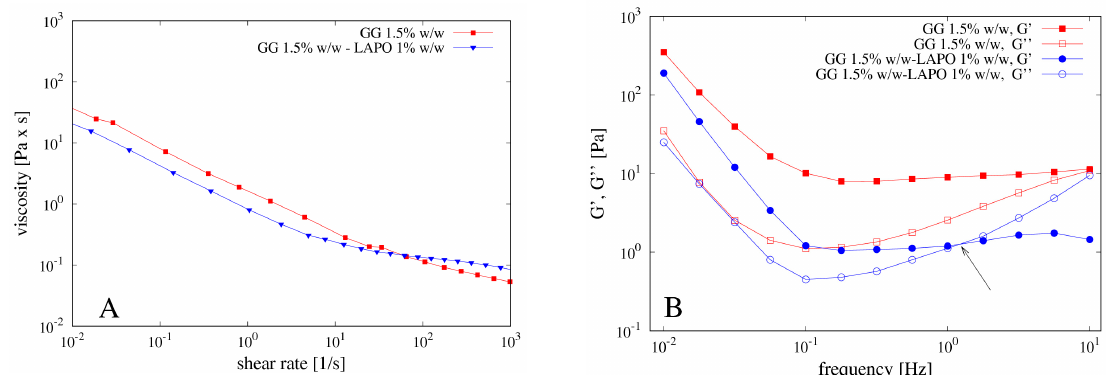
Figure 5. ( A ) Flow curves of GG solution with and without laponite and ( B ) mechanical spectra of the same solutions. Arrow indicates the inversion point G’’ ≈ G’ at a frequency of about 1 Hz for the mechanical spectra of the GG solution including laponite.